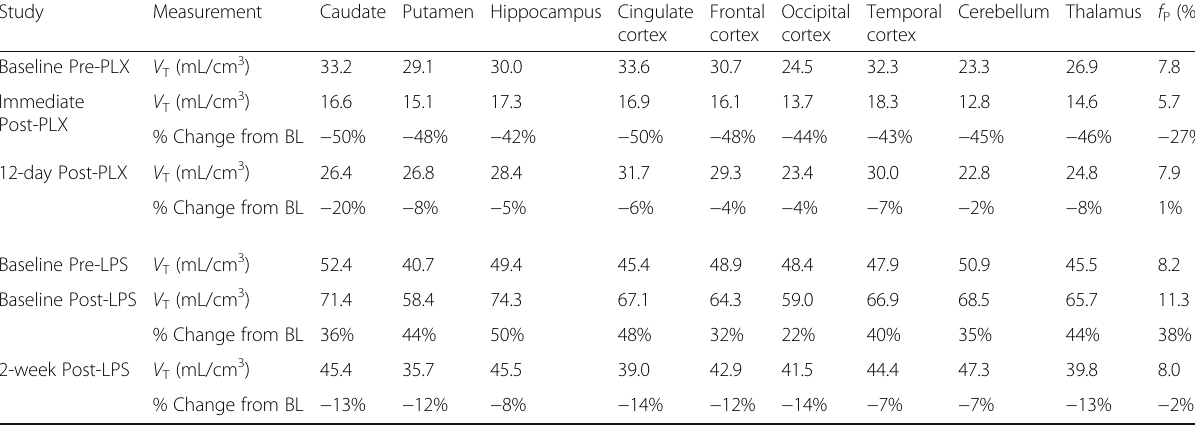
Table 1 [ 11 C]PBR28 experimental